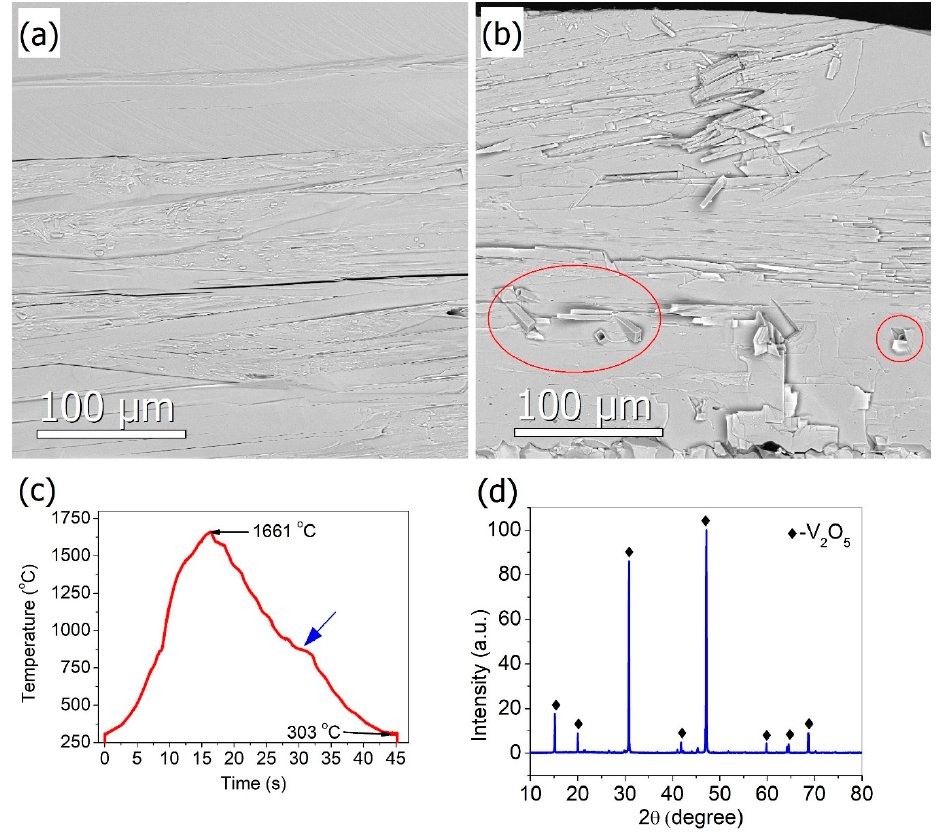
Figure 6. Characteristics of recrystallization product via heating with high peak temperature and cooling slowly: SEM image from ( a ) top view, ( b ) side view, ( c ) temperature vs. time curve during recrystallization, and ( d ) XRD pattern.